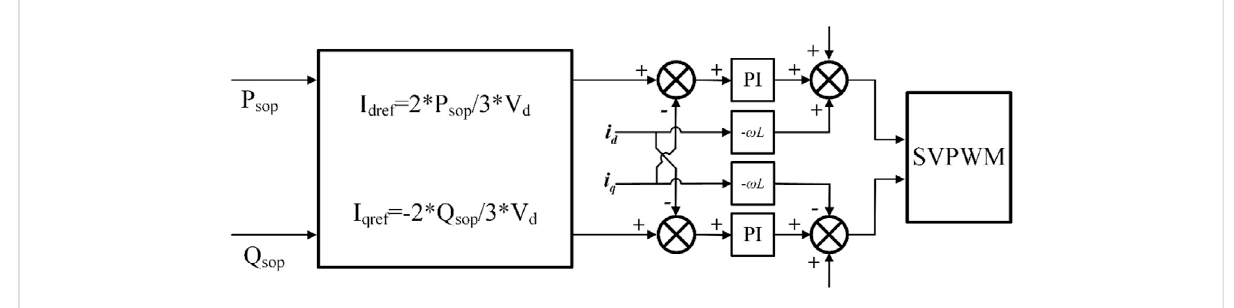
FIGURE 6 Schematic diagram of PQ control mode.